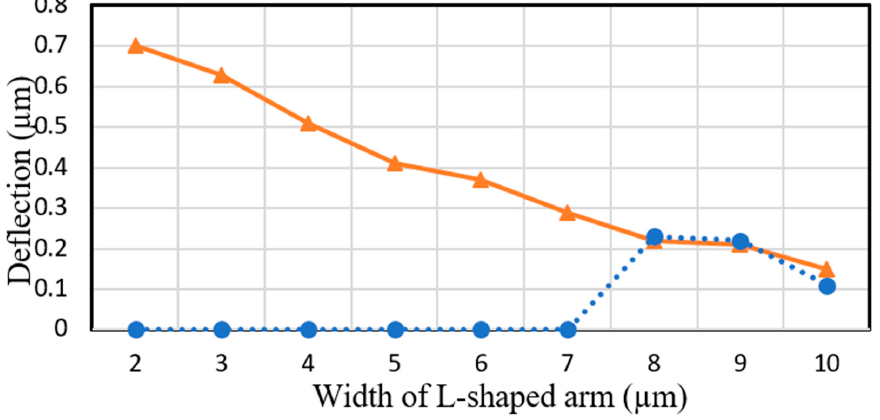
Figure 3. COMSOL simulation results illustrating deflection versus width of an individual arm without micromirror (solid line, triangle) and an L-shaped arm (dashed line, circle) connected to the micromirror.